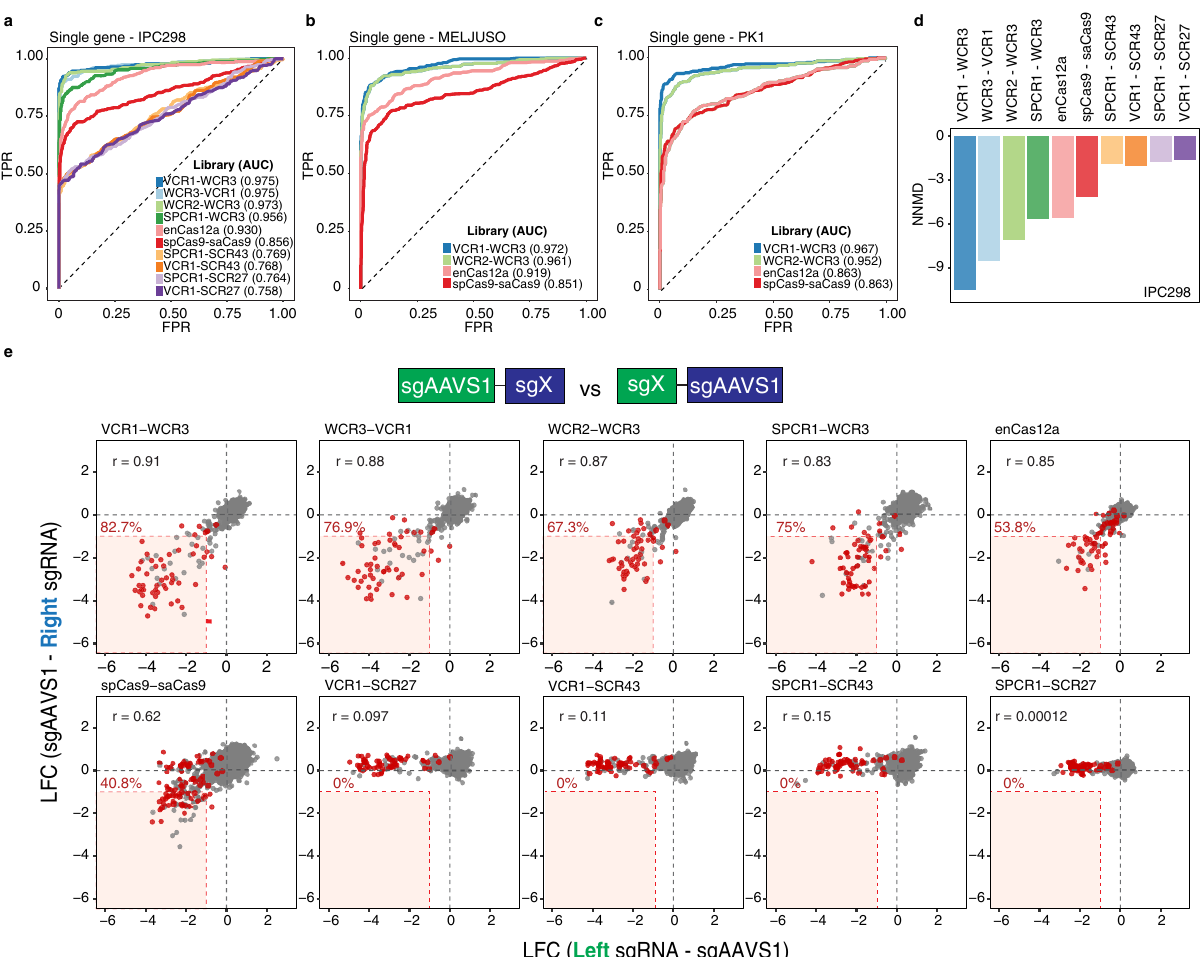
Fig. 2 Performance of combinatorial systems at the single-gene knockout level. a – c The single-gene receiver operating characteristic (ROC) — area under the curve (AUC) curves derived from pan-essential and nonessential genes across distinct libraries in ( a ) IPC298, ( b ) MELJUSO, and ( c ) PK1. AUC values are indicated in parentheses. d Separation between gene scores for common essential genes and nonessential genes computed using null-normalized median difference (NNMD). e Correlation between the average LFC of right versus left sgRNAs coupled with sgAAVS1 cutting control in IPC298. Pearson ’ s correlation coef fi cient is indicated ( r value) in black. Percentage of pan-essential genes with LFC less than − 1 for sgRNAs in both right and left positions are indicated in red. Pan-essential genes are annotated by red dots. Source data are provided in the Source Data fi